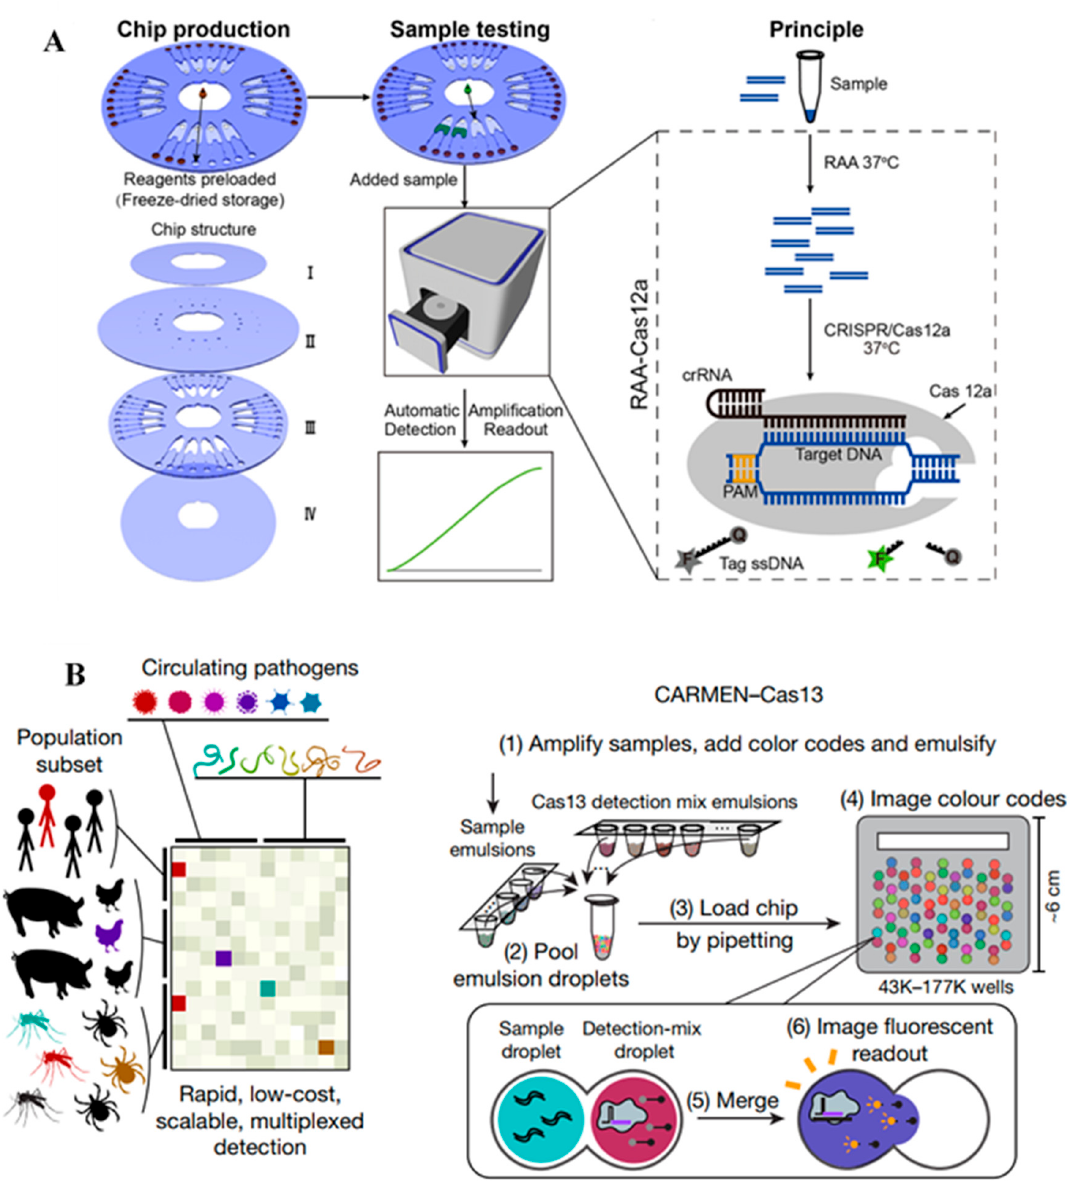
Figure 4. ( A ) The CASMEAN assay with a centrifugal microfluidic disc containing the freeze-dried CRISPR/Cas12 for long-term applications and fluorescent signal readouts [26]. ( B ) The CARMEN multiplex detection assay for 169 viruses is based on the colored map analysis created by four commercial fluorophores and Cas13 trans cleavage in a microarray chip [39]. Figures reprinted with permissions.